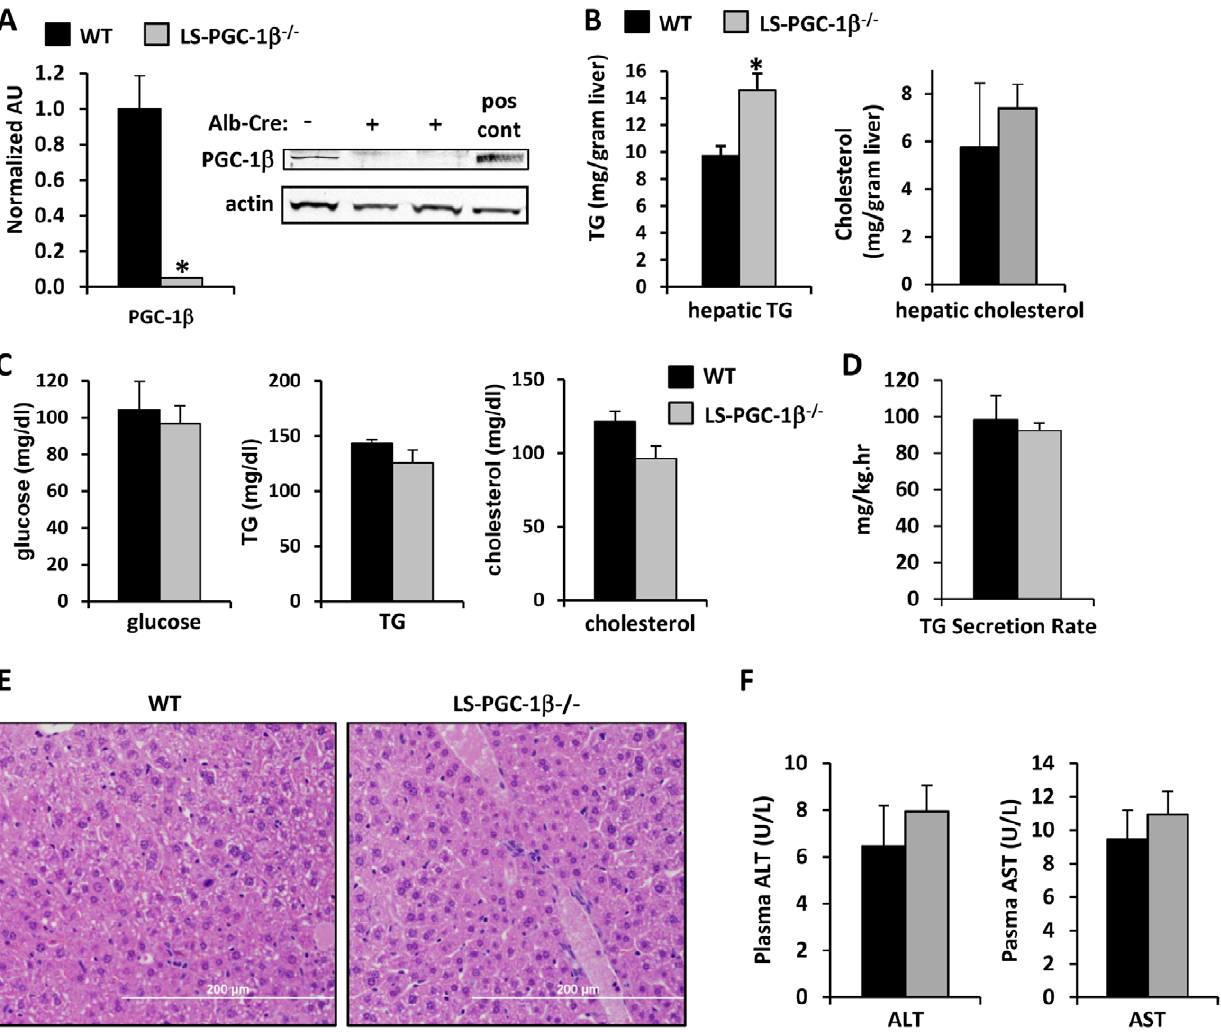
Figure 1. Liver-specific deletion of PGC-1 b . [ A ] The graph shows the expression of PGC-1 b (Ppargc1b) mRNA in liver of 6 week old female WT (fl/ fl) or littermate LS-PGC-1 b 2 / 2 mice (n=5). *P , 0.05 versus WT mice. Inset is a western blot using liver lysates from the same mice. Lysates from cells infected with an adenovirus to overexpress PGC-1 b were used as a positive control. [ B ] The graphs show hepatic triglyceride and cholesterol content in liver of 6 week old WT (fl/fl) or littermate LS-PGC-1 b 2 / 2 mice (n=5). [ C ] The graphs represent mean plasma glucose, triglyceride (TG), and cholesterol concentrations in WT and LS-PGC-1 b 2 / 2 littermate mice. [ D ] The graph depicts rates of TG secretion in WT and LS-PGC-1 b 2 / 2 littermate mice after injection with Triton WR-1339 to inhibit VLDL lipolysis. [ E ] Representative H&E stained sections of liver from 6 week old WT and LS-PGC- 1 b 2 / 2 littermate mice are shown. [ F ] The graphs represent mean plasma ALT and AST concentrations in WT and LS-PGC-1 b 2 / 2 littermate mice.